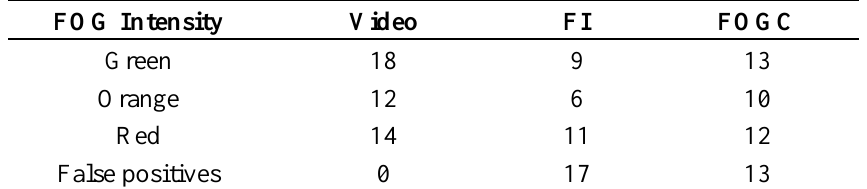
Table 1. FOG episodes detected through video analysis, via FI and FOGC algorithms. FOG Intensity Video FI FOGC Green